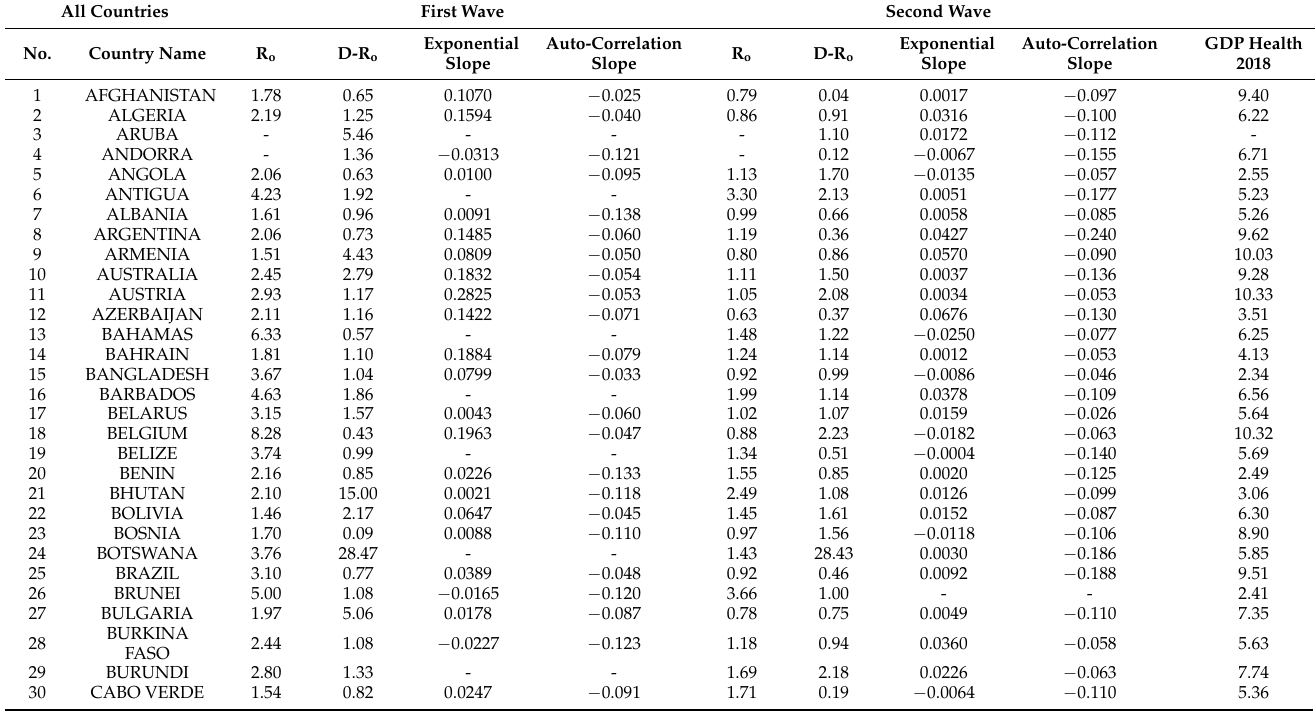
Table A1. Parameters for first and second waves for 195